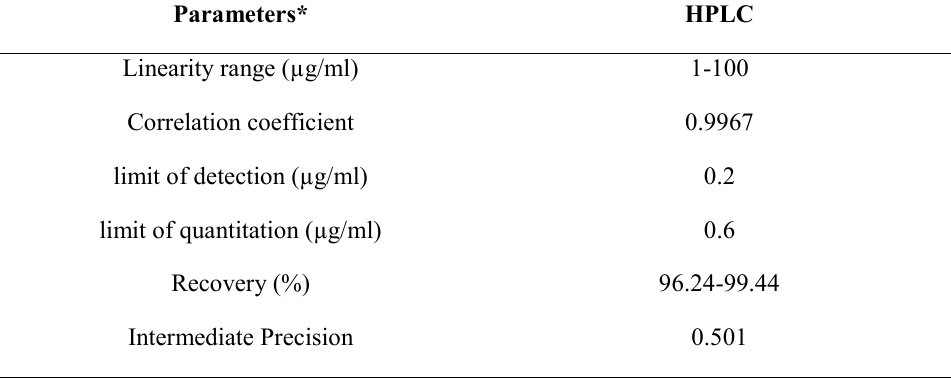
Table 1. Summary of validation